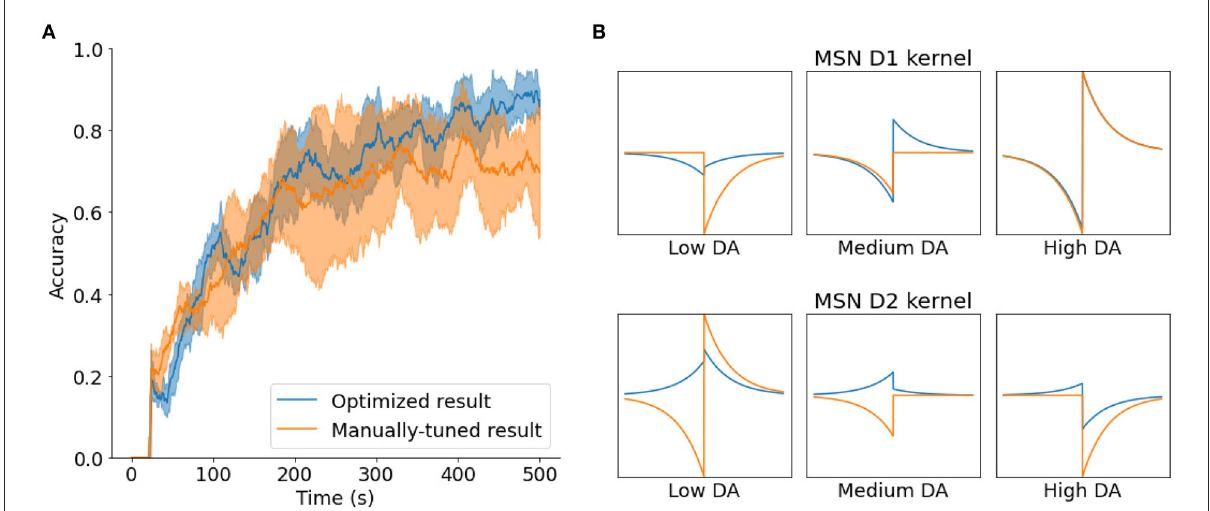
FIGURE6 (A) Comparison between one of the best results obtained with the SurrogateOpt optimization method (blue) with the best manually-tuned result (orange), with the mean and SD ( n = 5). (B) Comparison of parameters related with the STDE